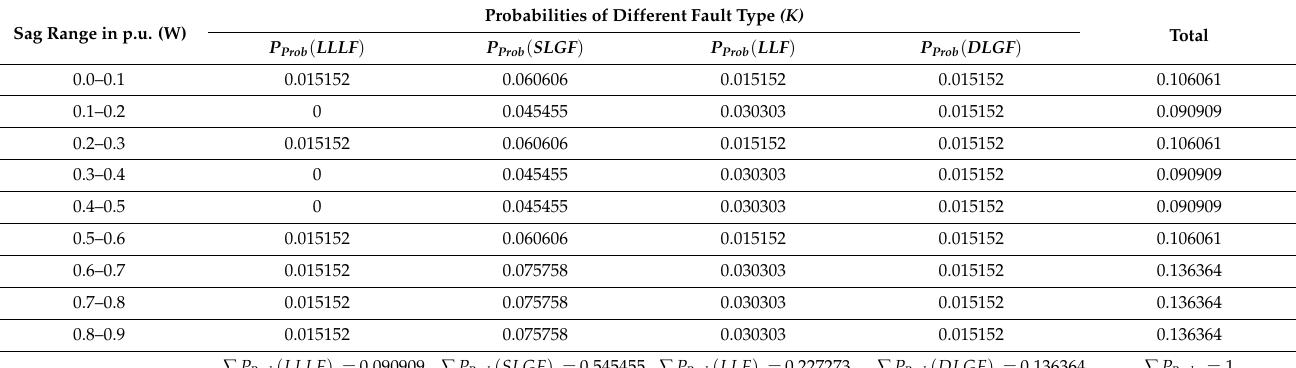
Table 1. Joint probability mass function of sag range and fault type for bus 15.